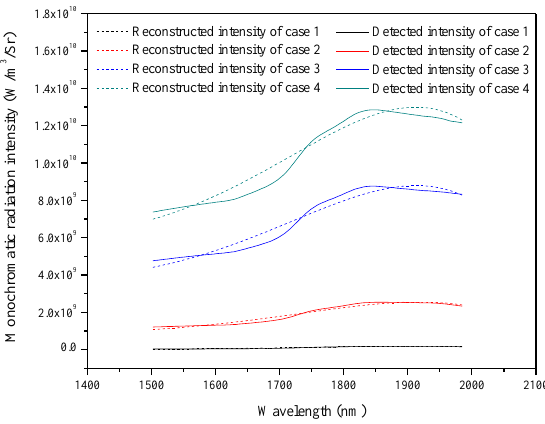
Figure 8. Comparisons of the detected and reconstructed monochromatic radiation intensities.